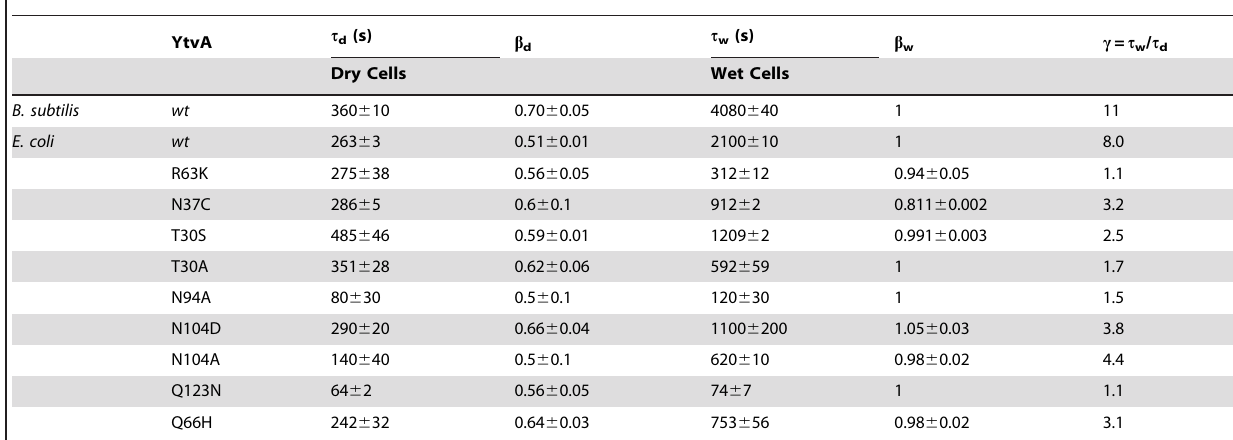
Table 1. Apparent time constants for the YtvAL to YtvAD relaxation at 25 u C.